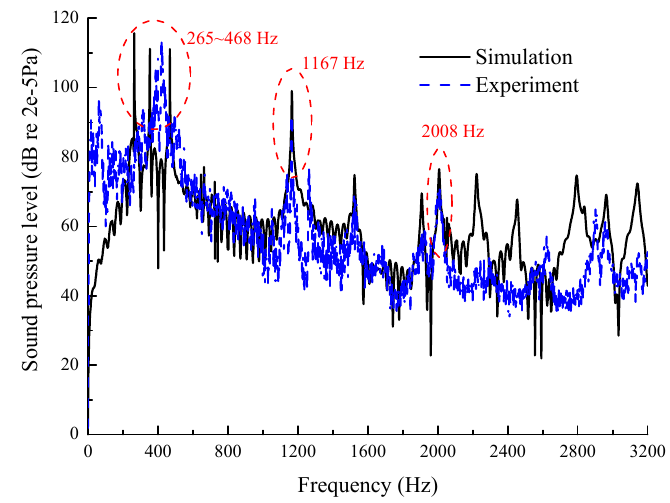
Figure 12. Comparison between simulation and experimental results of SPL of the leading wheel.